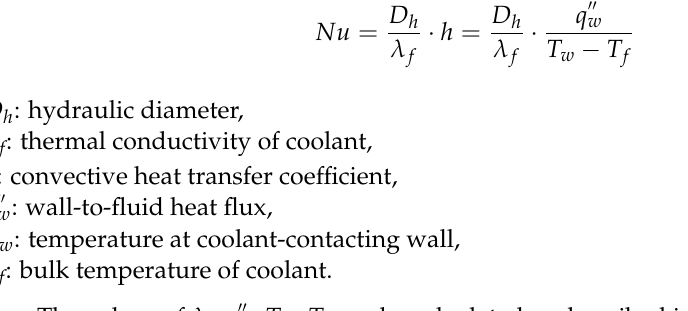
Figure 9. The calculated mean values of the wall (Tube-3) and bulk temperatures.